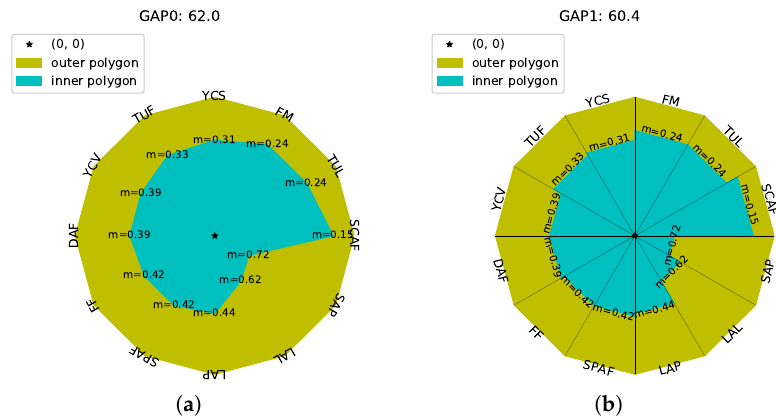
Figure 1. Example of the computation of Geometric Aggregation of Popularity (GAP) metrics for the artist “The Rasmus” on 2 April 2019. Version ( a ) GAP0 and ( b ) GAP1. The following abbreviations are used: DAF, Deezer Artist Fans; FF, Facebook Fans; FM, Facebook Mentions; LAL, Last.fm Artist Listeners; LAP, Last.fm Artist Plays; SCAF, Soundcloud Artist Followers; SPAF, Spotify Artist Followers; SAP, Spotify Artist Popularity; TUF, Twitter User Followers; TUL, Twitter User Listed; YCS, YouTube Channel Subscribers; YCV, YouTube Channel